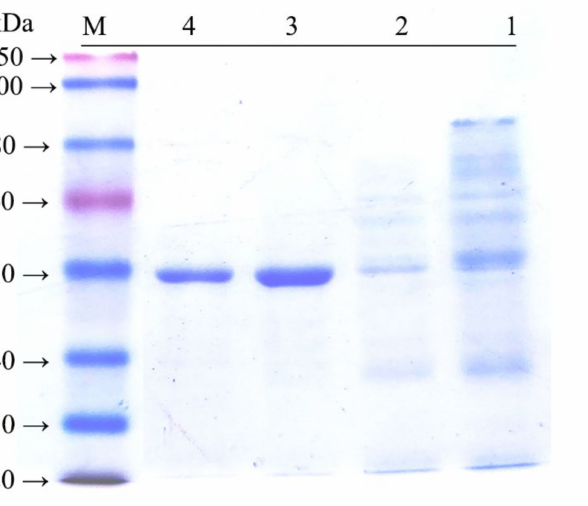
Figure 2. The overall ( a ), TIM-barrel ( b ), and dimeric ( c ) structures of endo- β -1,4-xylanase from Streptomyces sp. T7 (XynST7). The conserved catalytic sites are labeled.